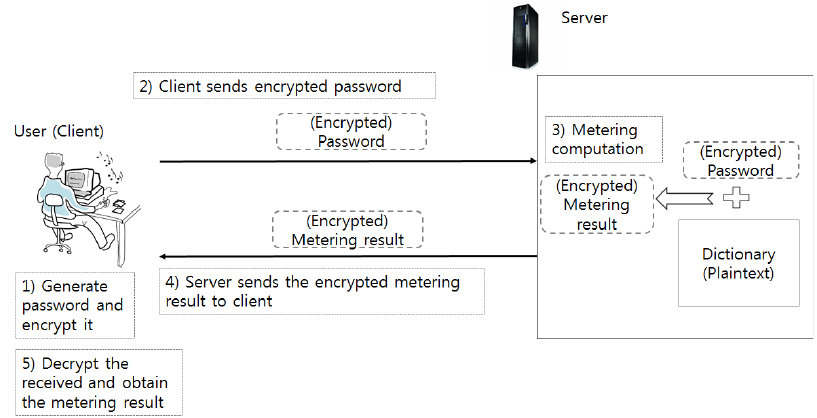
Figure 2. Encrypted password metering